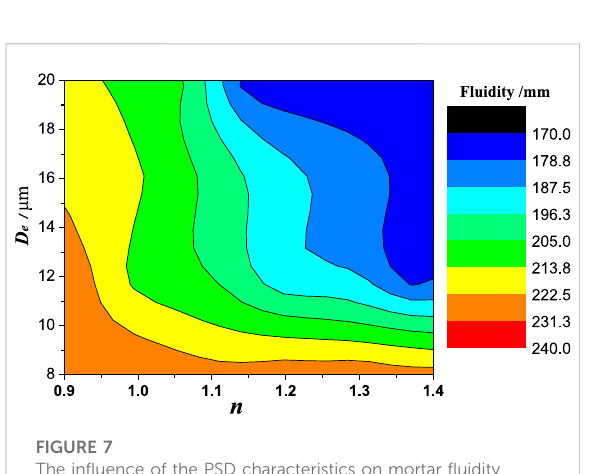
FIGURE 7 The in fl uence of the PSD characteristics on mortar fl uidity with PCE.